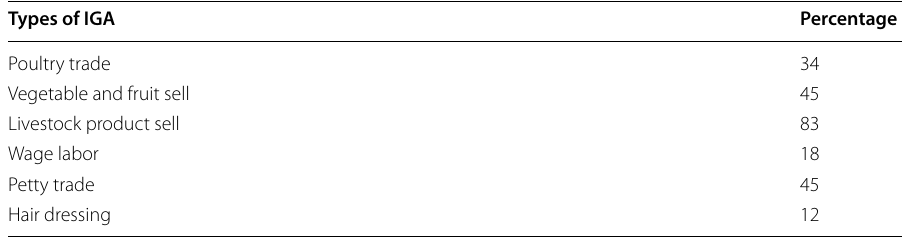
Table 4 Types of income generating activities women engaged in Types of